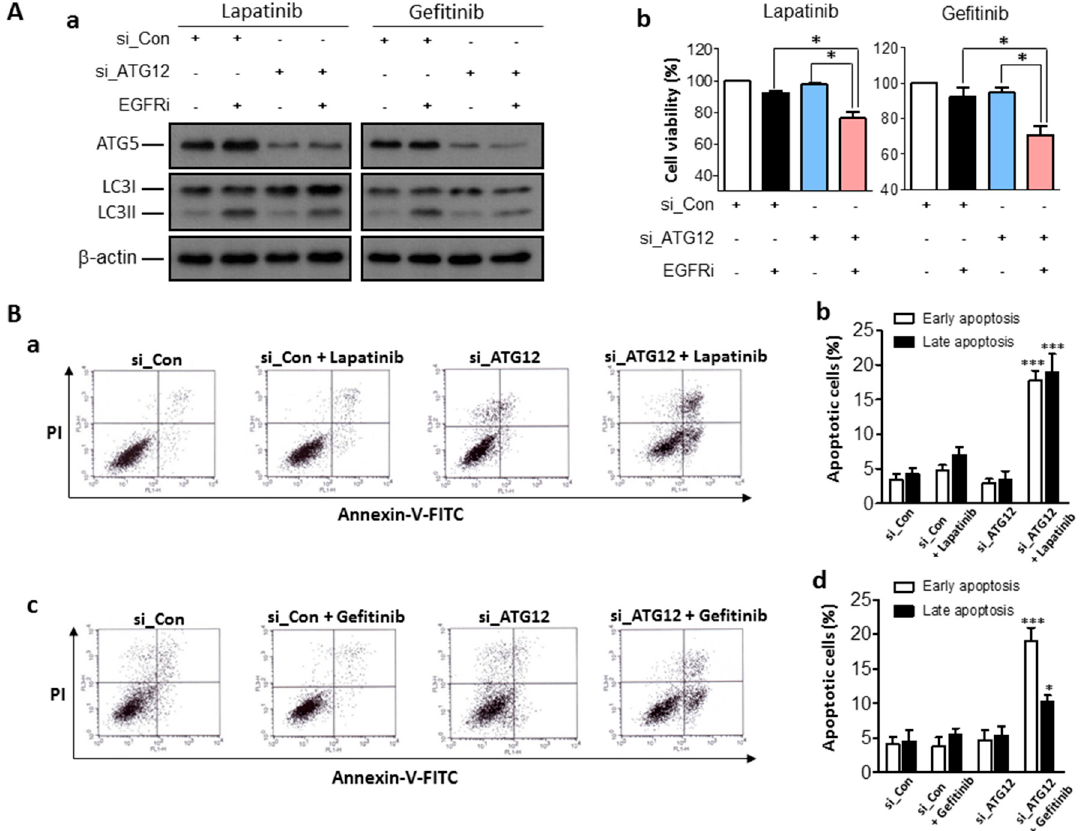
Figure 4. Effects of EGFR inhibitors with autophagy regulatory gene inhibition on T24 human bladder cancer cells. ( A ) ( a ) Western blot analysis to determine the knock-down efficiency and autophagy suppression by transfection of ATG12-siRNA (si_ATG12) in T24 cells, combined with the treatment of EGFR inhibitors (EGFRi). Scramble siRNA (si_Con; 50 nM) was used as a negative control of (si_ATG12). ( b ) Cell viability assay of T24 cells under the same treatment condition of EGFRi (5 μ M) and si_ATG12 (50 nM) for 48 h; data are represented by the mean percentage of the control ± SEM ( n = 3, * p < 0.05); ( B ) apoptosis assay by flow cytometry to examine the synergistic effects of EGFRi (5 μ M) and genetic inhibition of autophagy activity by transfection of si_ATG12 (50 nM) for 48 h in T24 cells. ( a , b ) Lapatinib and ( c , d ) gefitinib were used as EGFRi. ( a , c ) representative results of the apoptosis assay and ( b , d ) quantitative data as bar graphs, indicating the proportion of early and late apoptotic cell death. Values are shown as the mean ± SEM ( n = 3, * p < 0.05, *** p <0.001). si_Con (50 nM) was used as a negative control of si_ATG12.